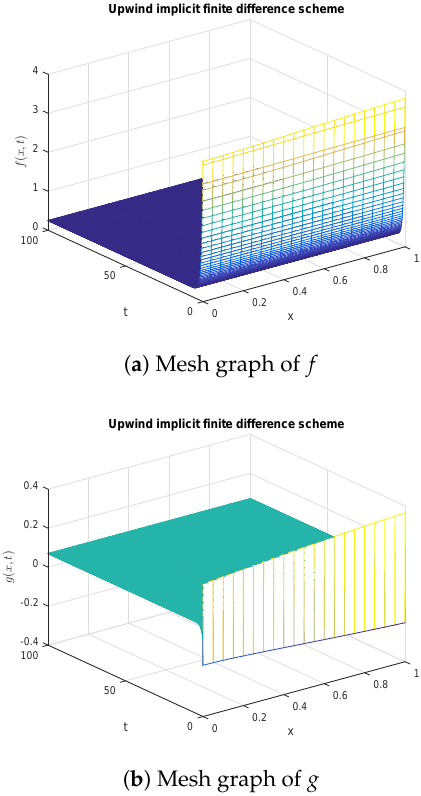
Figure 3. Graphical solution of f , g (concentration of substances) using upwind implicit method at a = 3.5, b = 0.25, χ 1 = 2, χ 2 = χ ∗